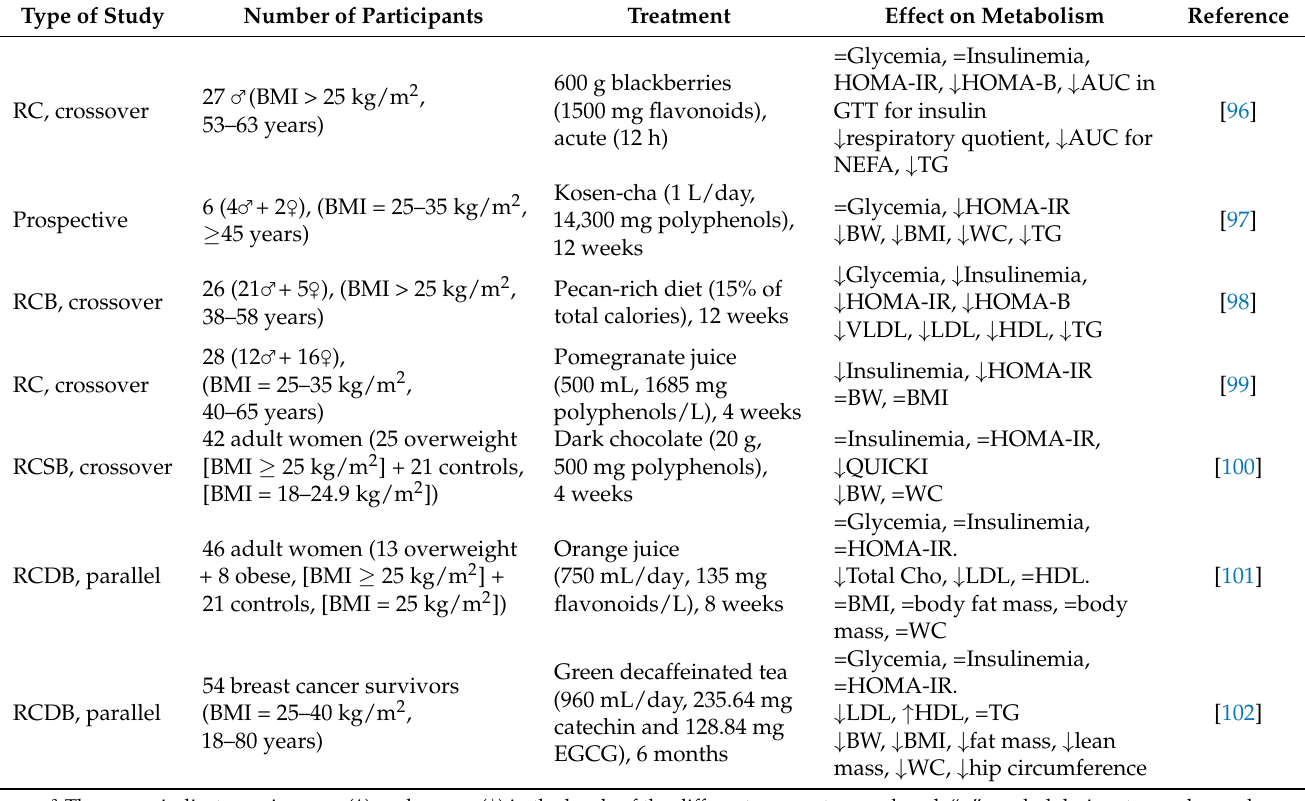
Table 5. Human interventional trials of the effects of flavonoid and flavonoid-rich food intake on insulin resistance during obesity a